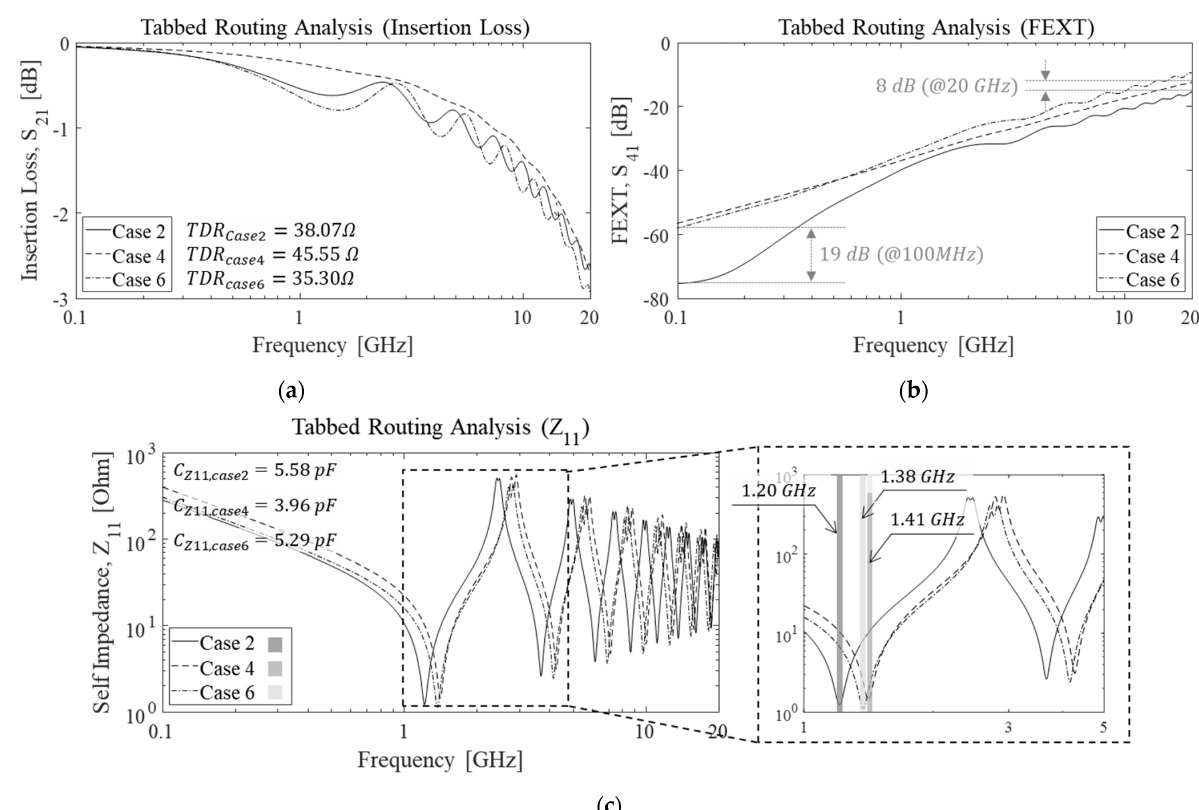
Figure 10. Frequency domain analysis of tabbed routing with or without tabs for comparison of cases 1, 3, and 5 in terms of ( a ) insertion loss, ( b ) FEXT, and ( c ) self-impedance, Z 11 ; and cases 2, 4, and 6 in terms of ( c ) insertion